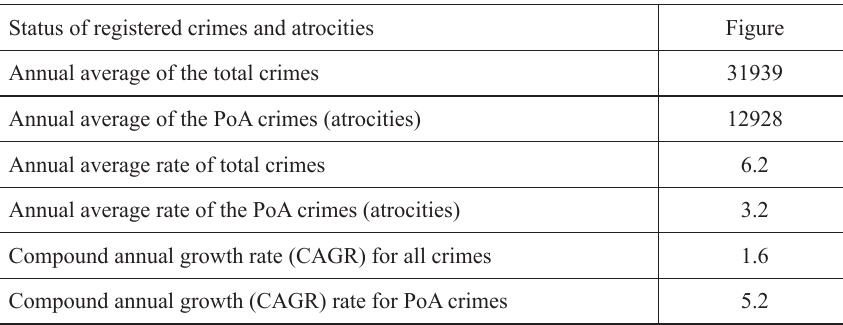
Table 1. Status of registered crimes and atrocities on scheduled castes in India, 1995-2015 Status of registered crimes and atrocities Figure Annual average of the total crimes 31939 Annual average of the PoA crimes